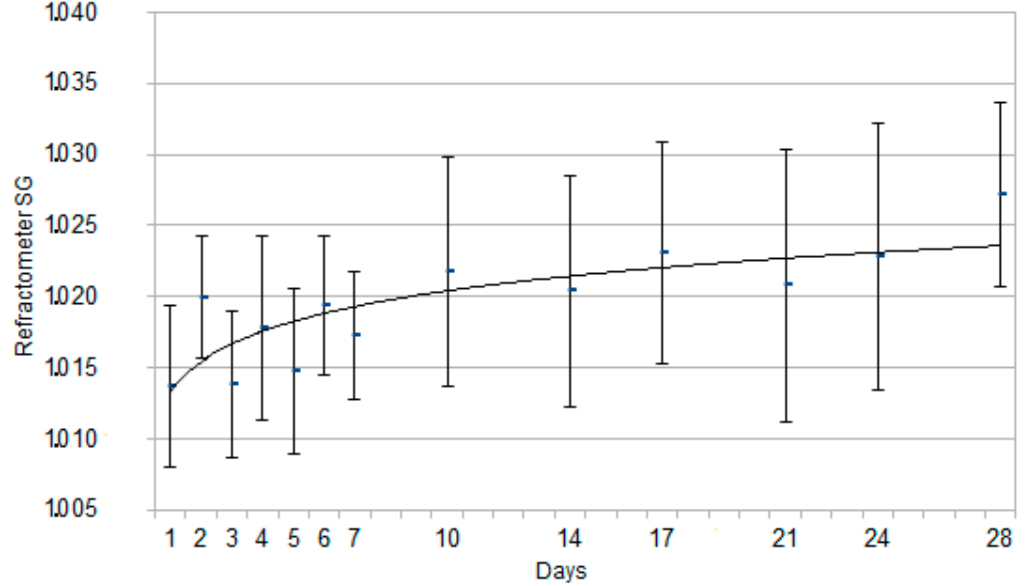
Figure 3. Graph for each time point representing Specific Gravity (SG) recorded by refractometer, expressed as mean ± SD, in the 48 Great Dane puppies from birth to 28 days of age. The continuous curve represents the tendency line for this